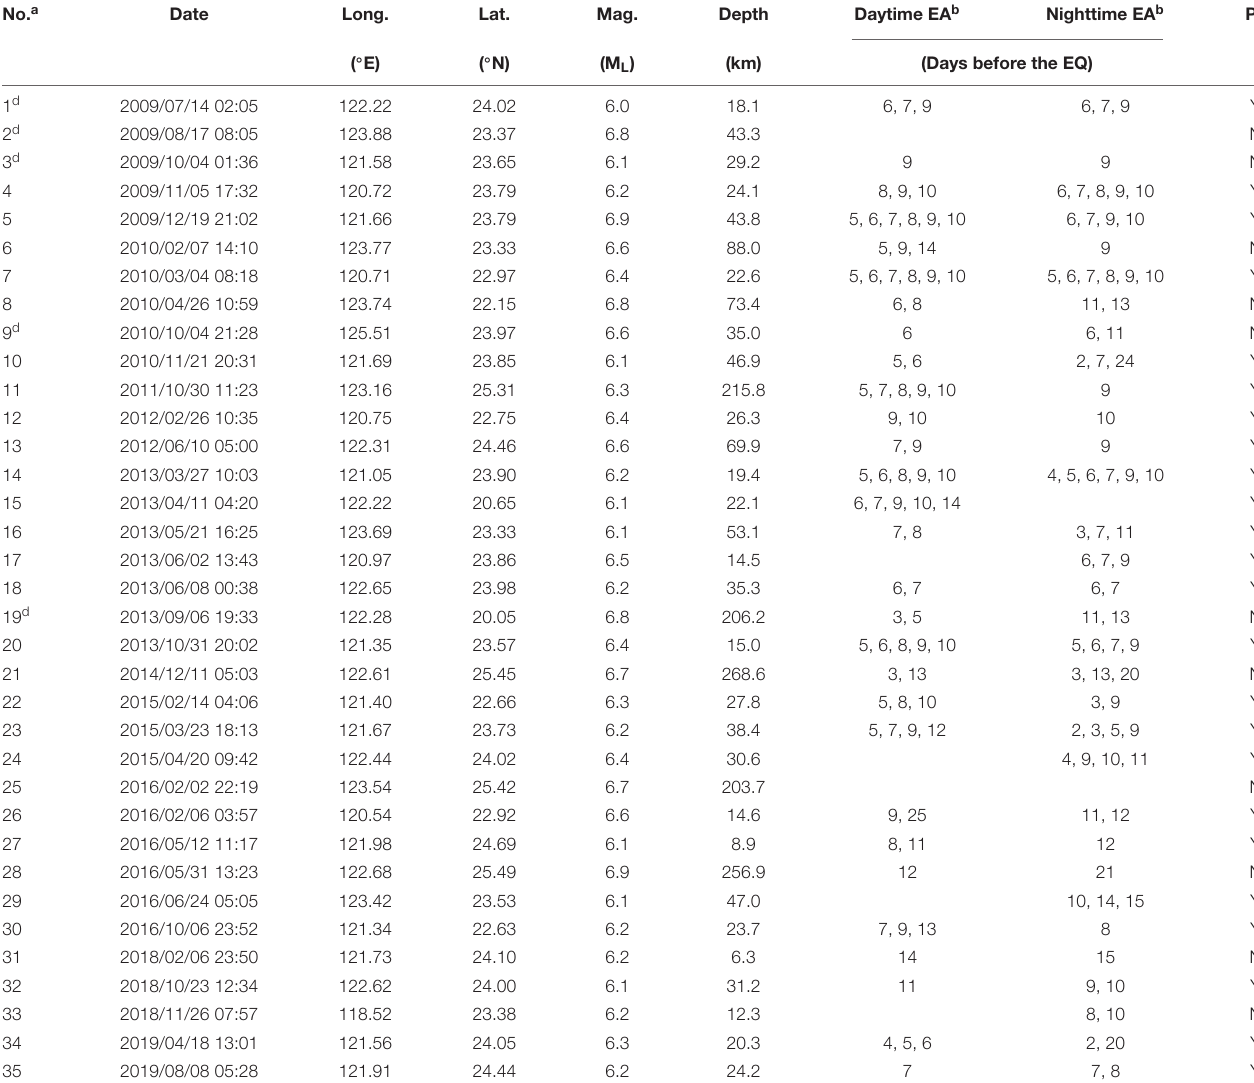
TABLE 1 | Catalog of OLR E Index anomalies (EA) and related earthquakes occurring around Taiwan from 2009 to 2019. No.